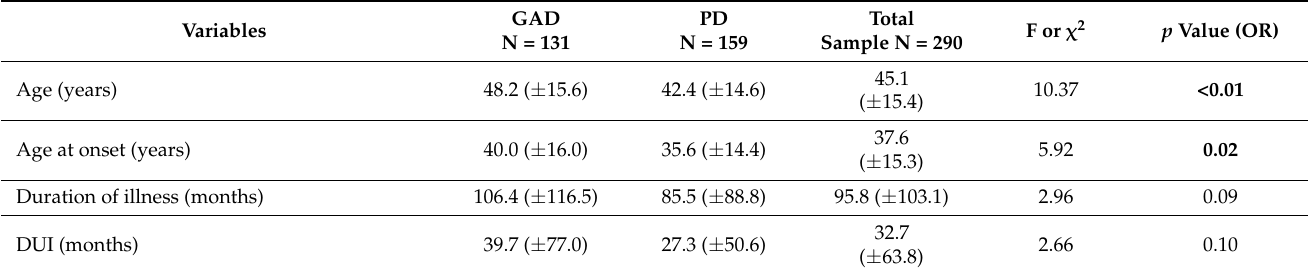
Table 1. Descriptive and univariate analyses: comparison between GAD and PD in terms of sociode- mographic and clinical